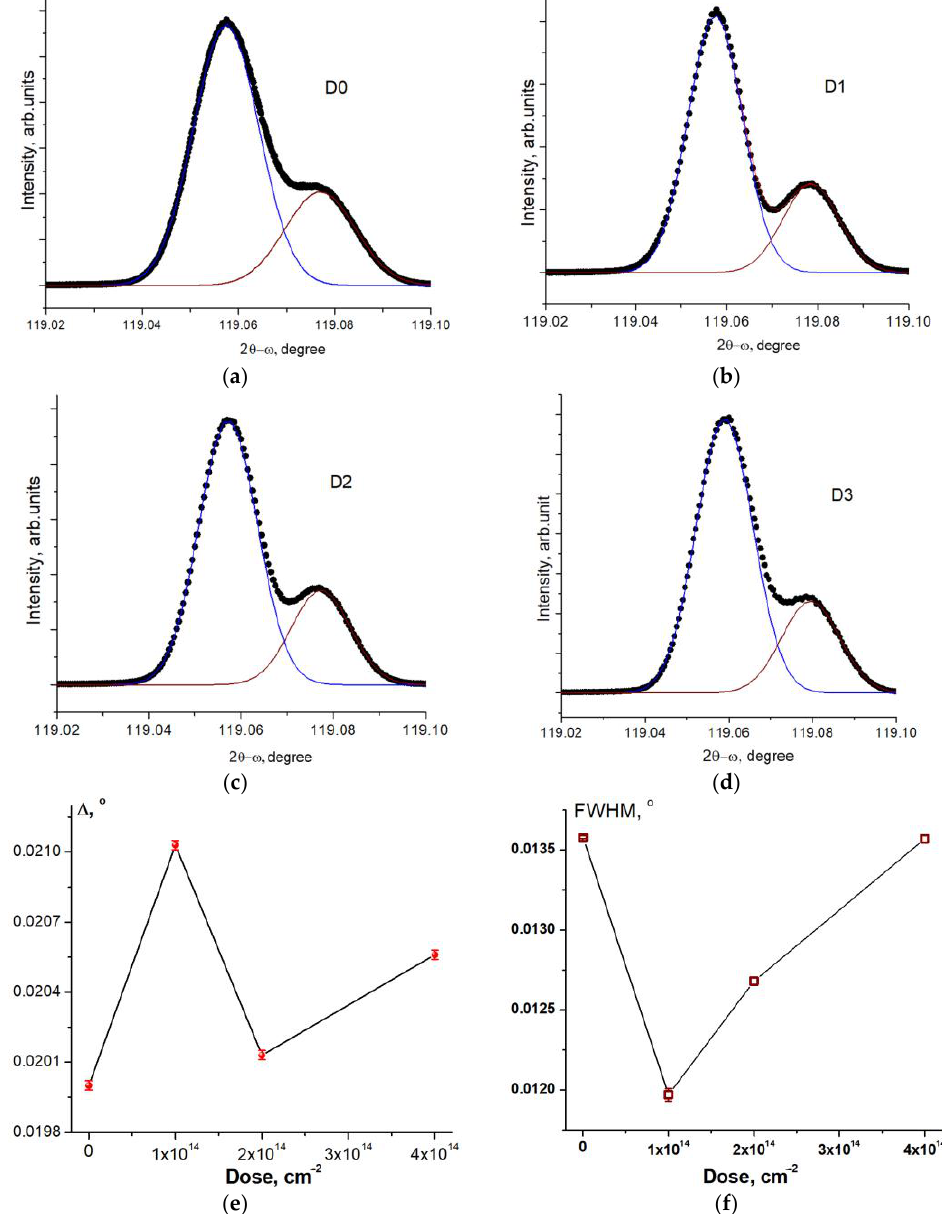
Figure 3. Rocking curves ((888) reflection) of YIG/GGG heterostructures implanted with Ne + ions ( E = 82 keV) with doses of 0, 1 × 10 14 , 2 × 10 14 and 4 × 10 14 сm −2 (dots — experimental data, line — fitting) ( a – d ); dependences of the angular differences between the YIG and GGG reflexes ( e ) and the FWHM of the YIG reflex ( f ) on the ion implantation dose.